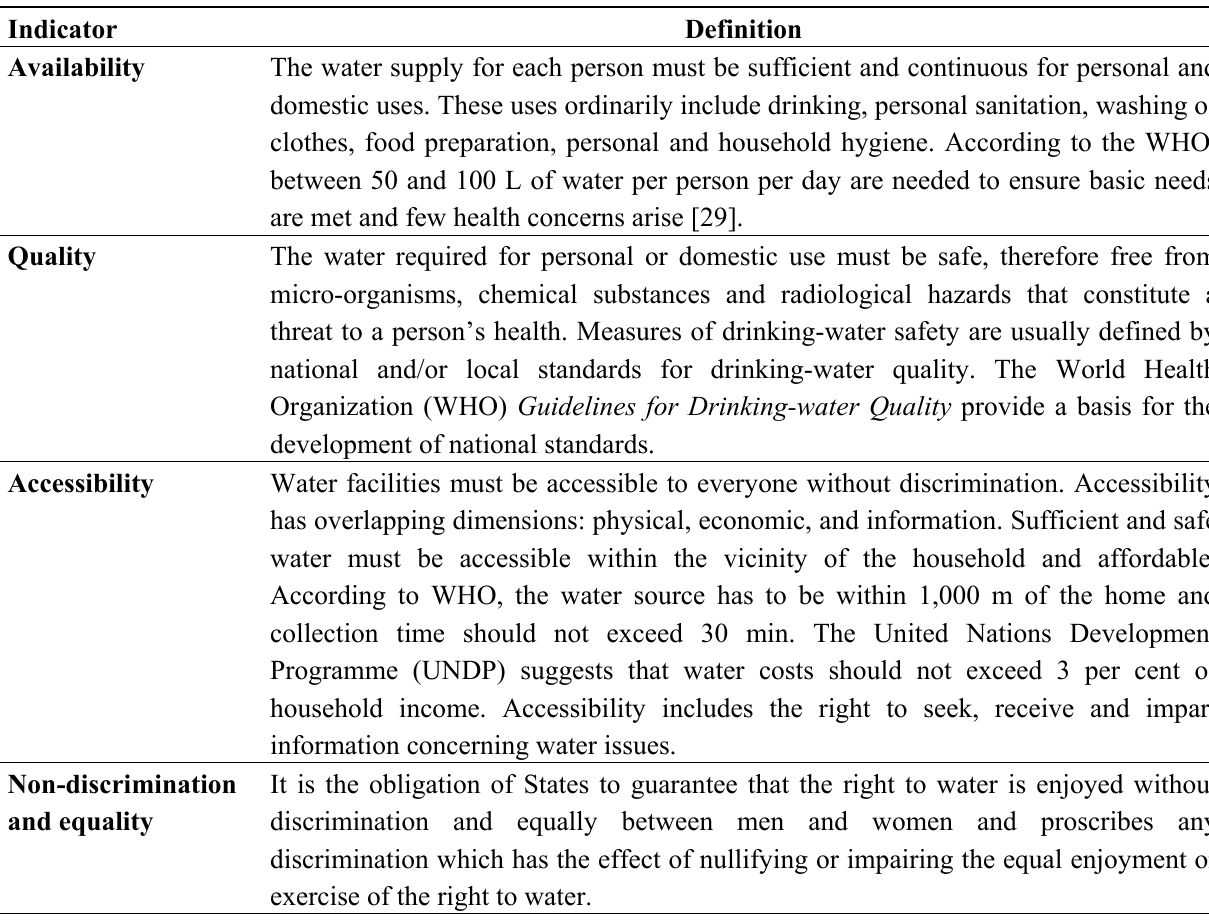
Table 2. The right to water (Adapted from [ General Comment No. 15: The Right to Water ] . by UNCESCR, copyright (2003) United Nations. Reprinted with permission of the United